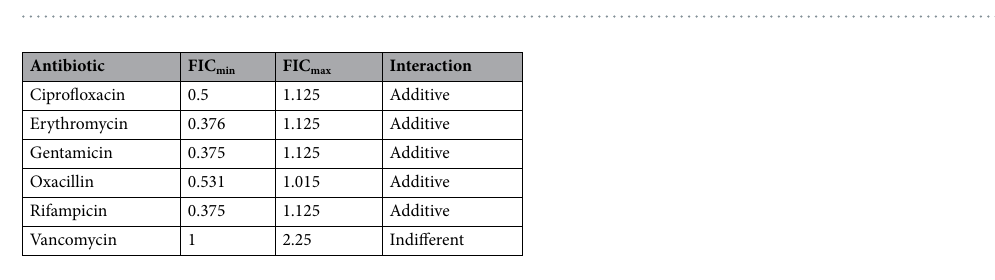
Figure 2. Isobolograms showing interactions between 135C and antibacterial agents. The dotted gradient line represents the theoretical line of additivity.